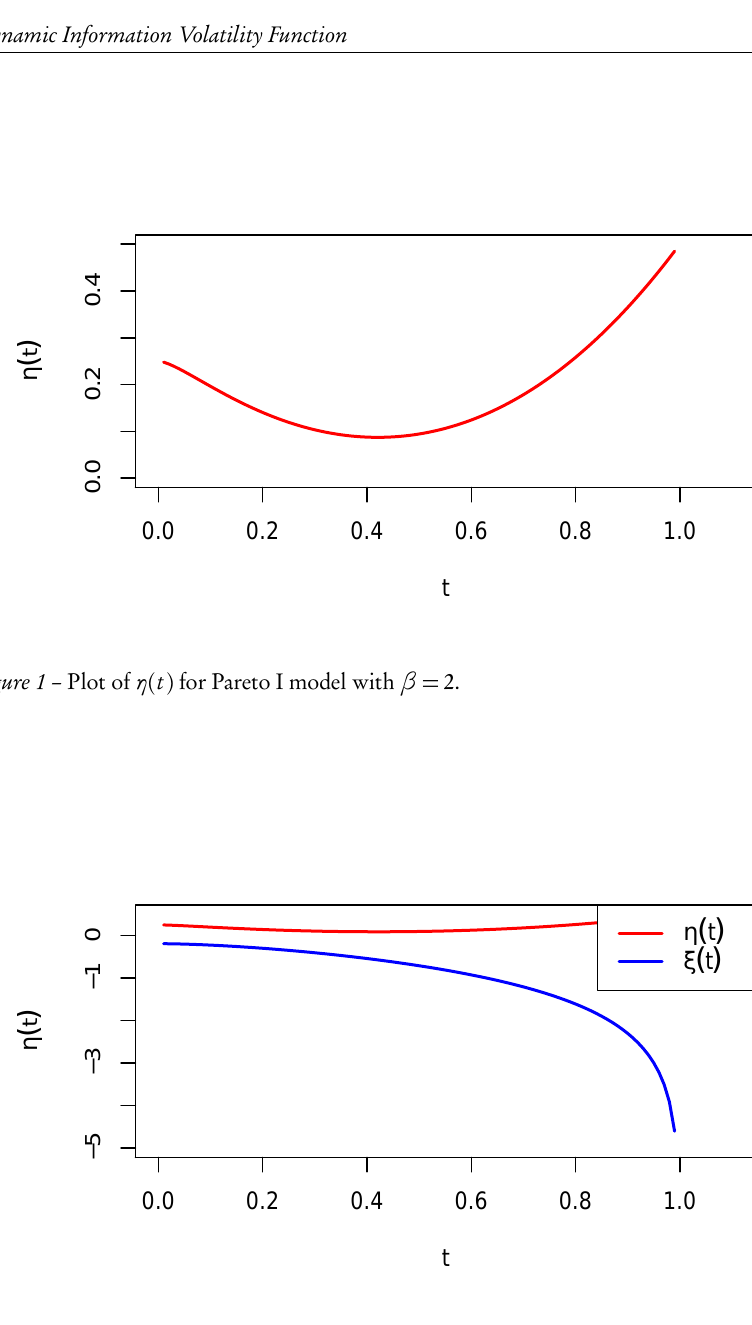
Figure 2 – Plot of ξ ( t ) and η ( t ) for Pareto I model with β =